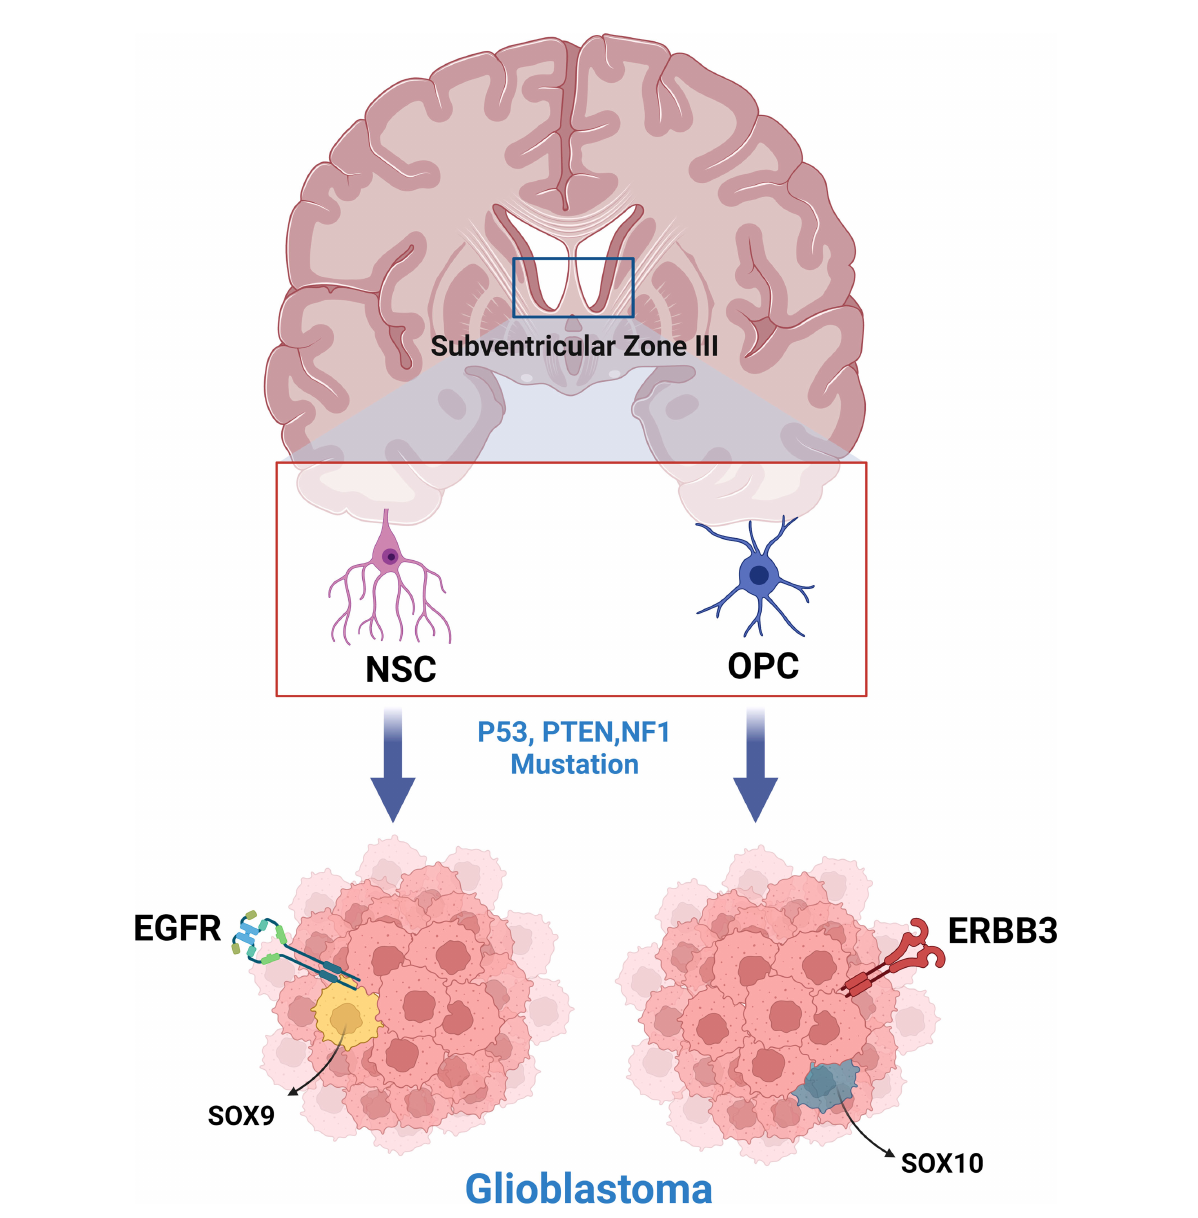
FIGURE 1 Neural stem cells and oligodendrocyte progenitor cells of the subventricular zone produce phenotypically and molecularly distinct glioblastoma tumors when engineered to express common glioblastoma driver